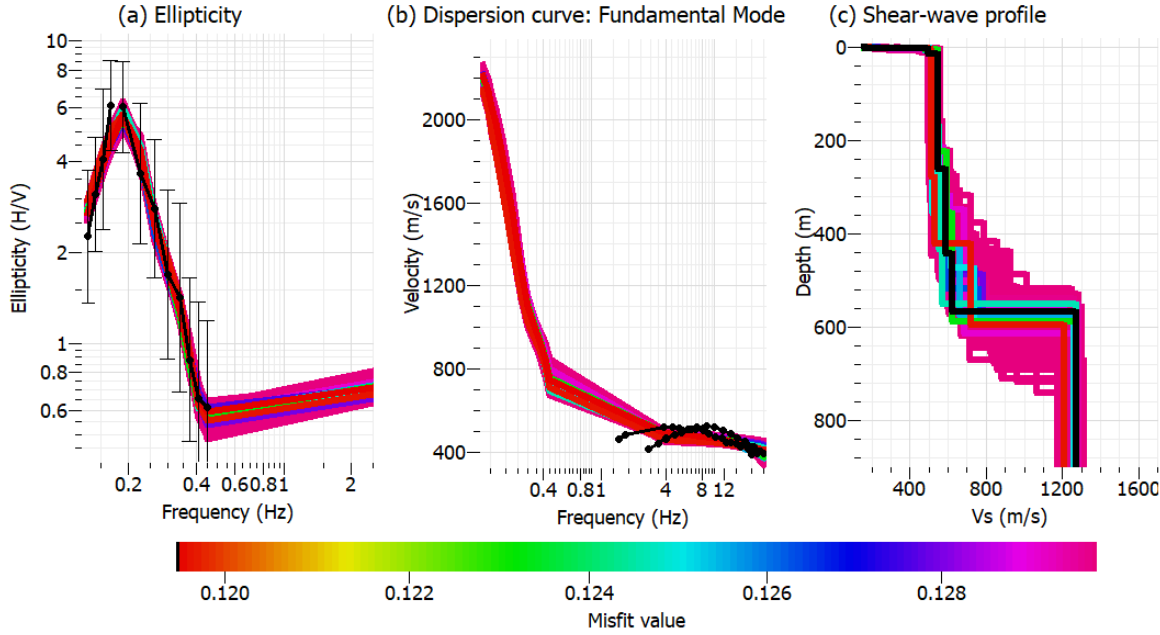
Figure 12. Inversion results in a point in Mejillones using ellipticity of the Rayleigh waves from the H/V curve. ( a ) adjust- ment of the ellipticity curve between the observed curve (black line) and the best models. ( b ) adjustment of the dispersion curve between the observed curve (black line) and the best models. ( c ) models obtained from the inversion. Black line corresponds to the best model.